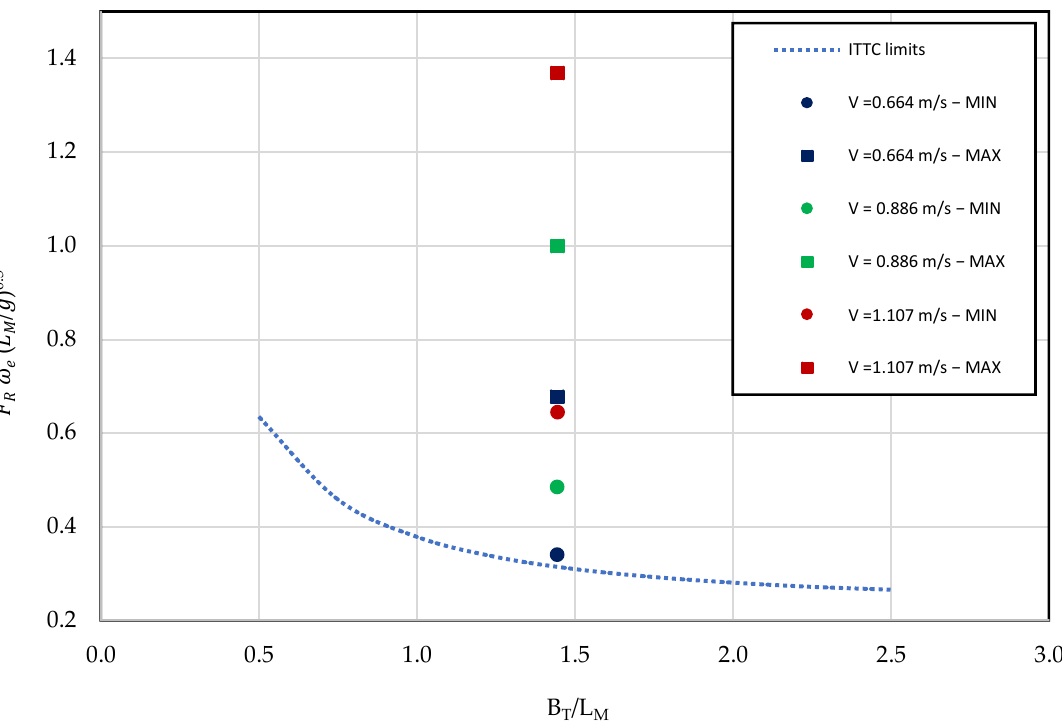
(cid:112) L M / g for each ship speed compared to the Figure 3. Maximum and minimum values of F R · ω e Figure 3. Maximum and minimum values of 𝐹 𝑅 ∙ 𝜔 𝑒 √𝐿 𝑀 /𝑔 for each ship speed compared to the recommended ITTC limits for side-wall recommended ITTC limits for side-wall interference.